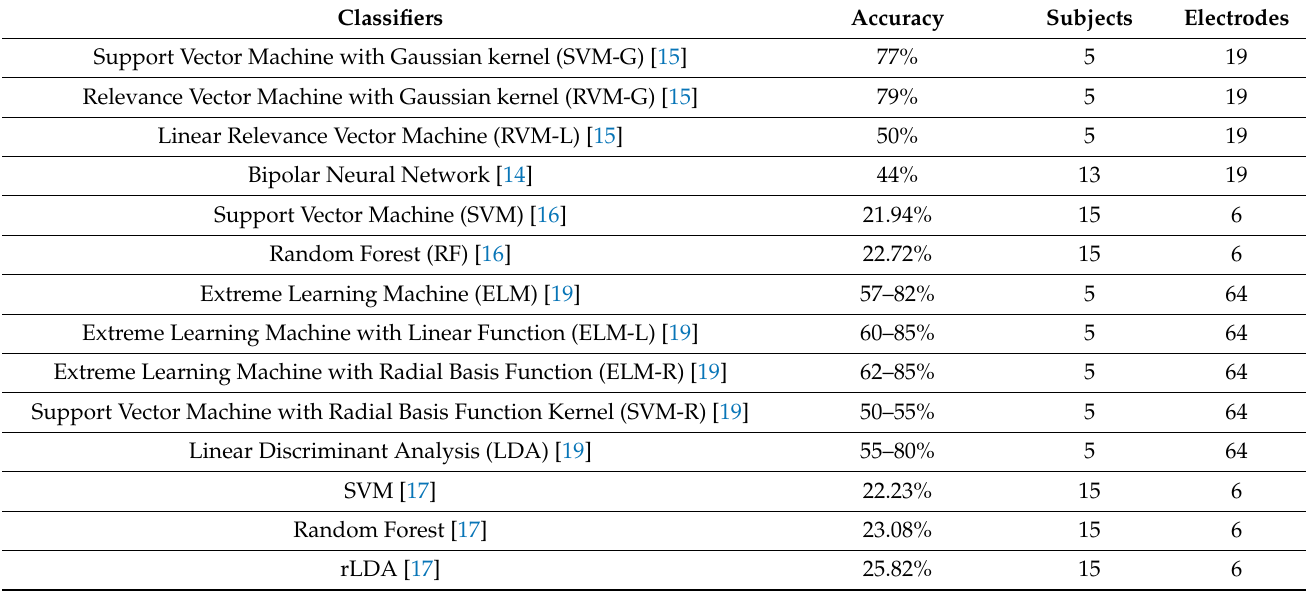
Table 1. Machine learning classifiers used for imagined vowel recognition (/a/,/e/,/i/,/o/,/u/). Classifiers Accuracy Subjects Electrodes